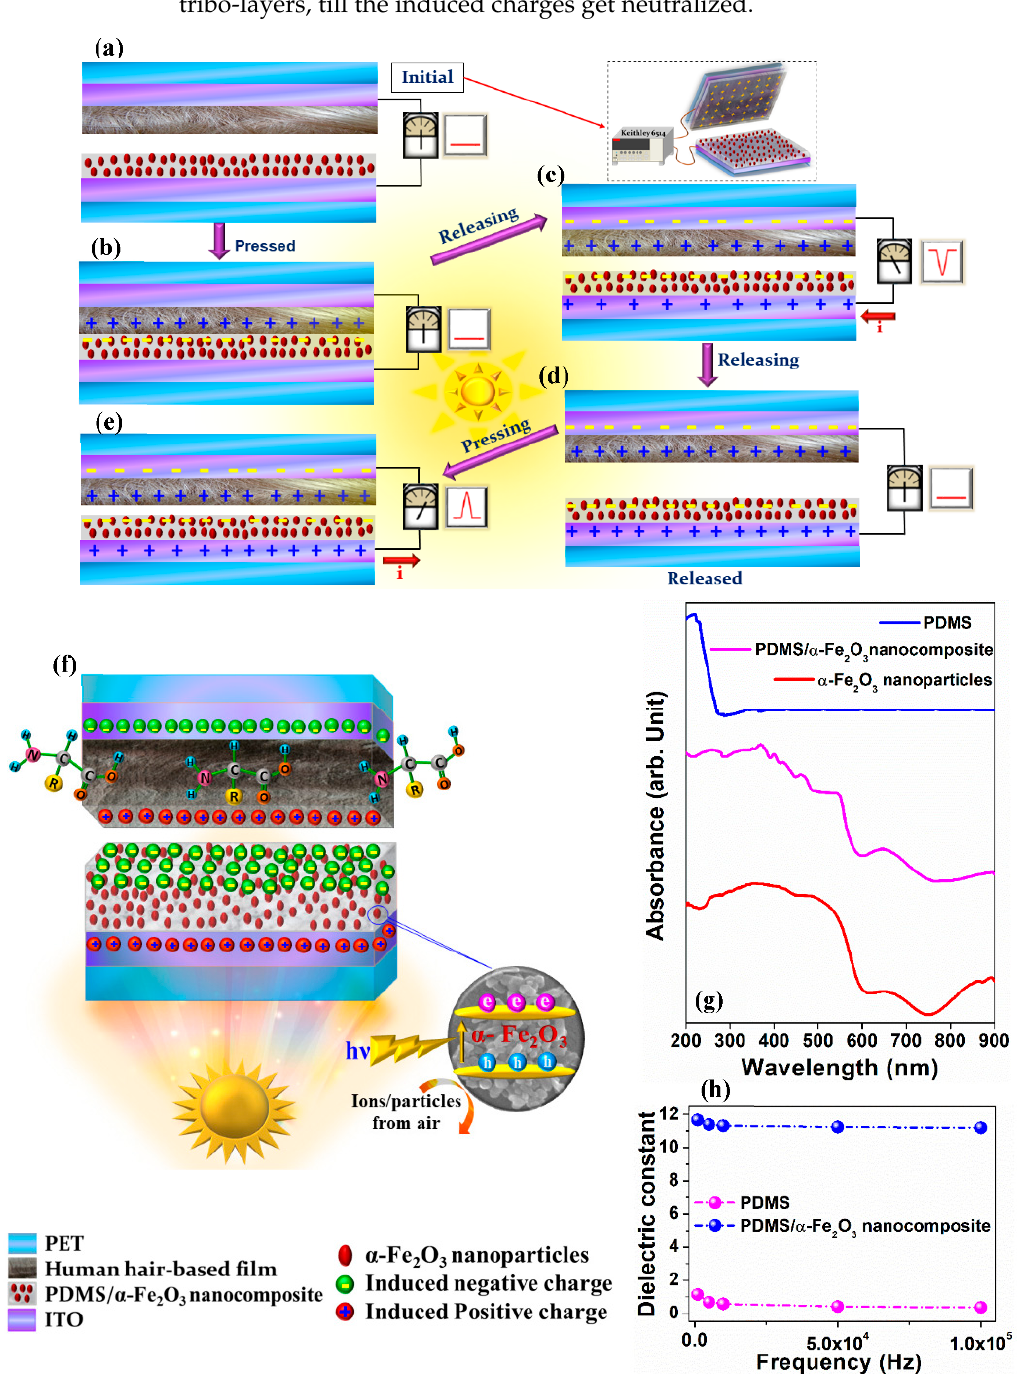
(Figure 7e), electrons are pushed back from the top to the bottom current collector, since the electrostatic potential difference is recompensed for by the opposite charges on both tribo-layers, till the induced charges get neutralized.